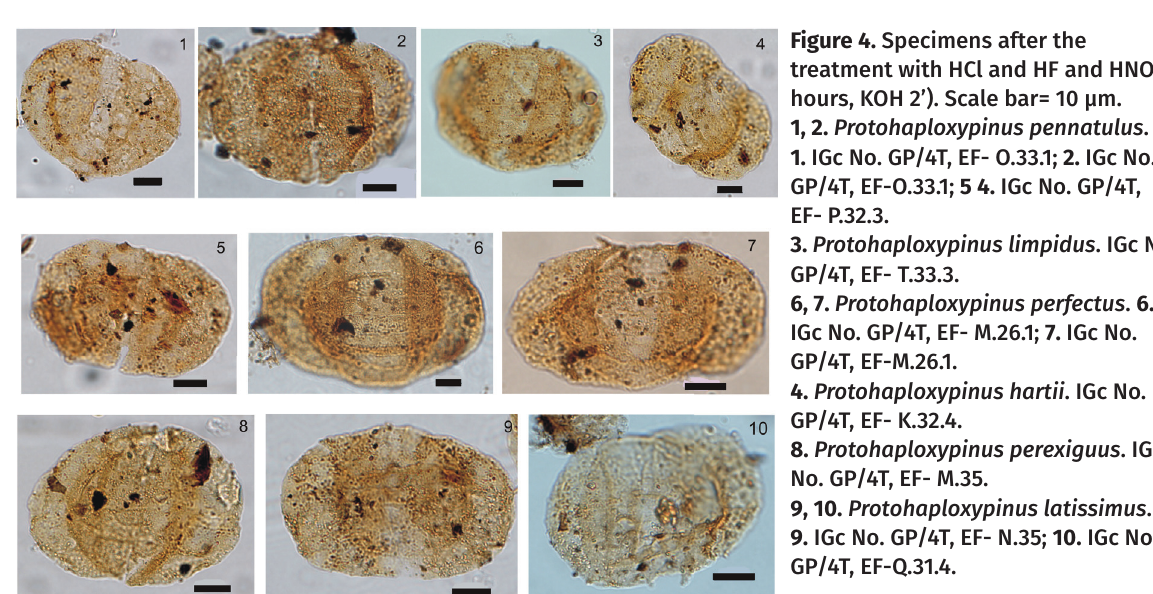
Figure 4. Specimens after the treatment with HCl and HF and HNO hours, KOH 2’). Scale bar= 10